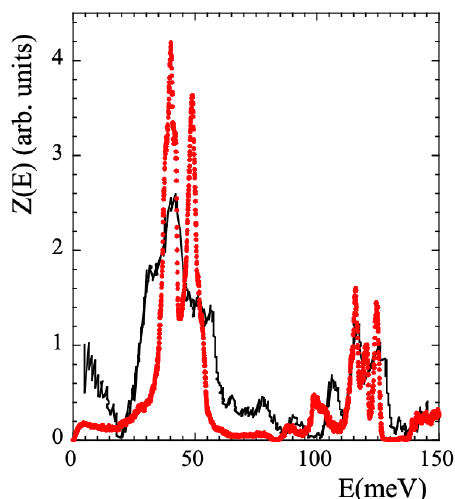
Figure 2. Comparison of the VDOS obtained from measurements on a fully hydrogenated PIB sample [42] (black line) and calculated from the simulations (red circles) at 25